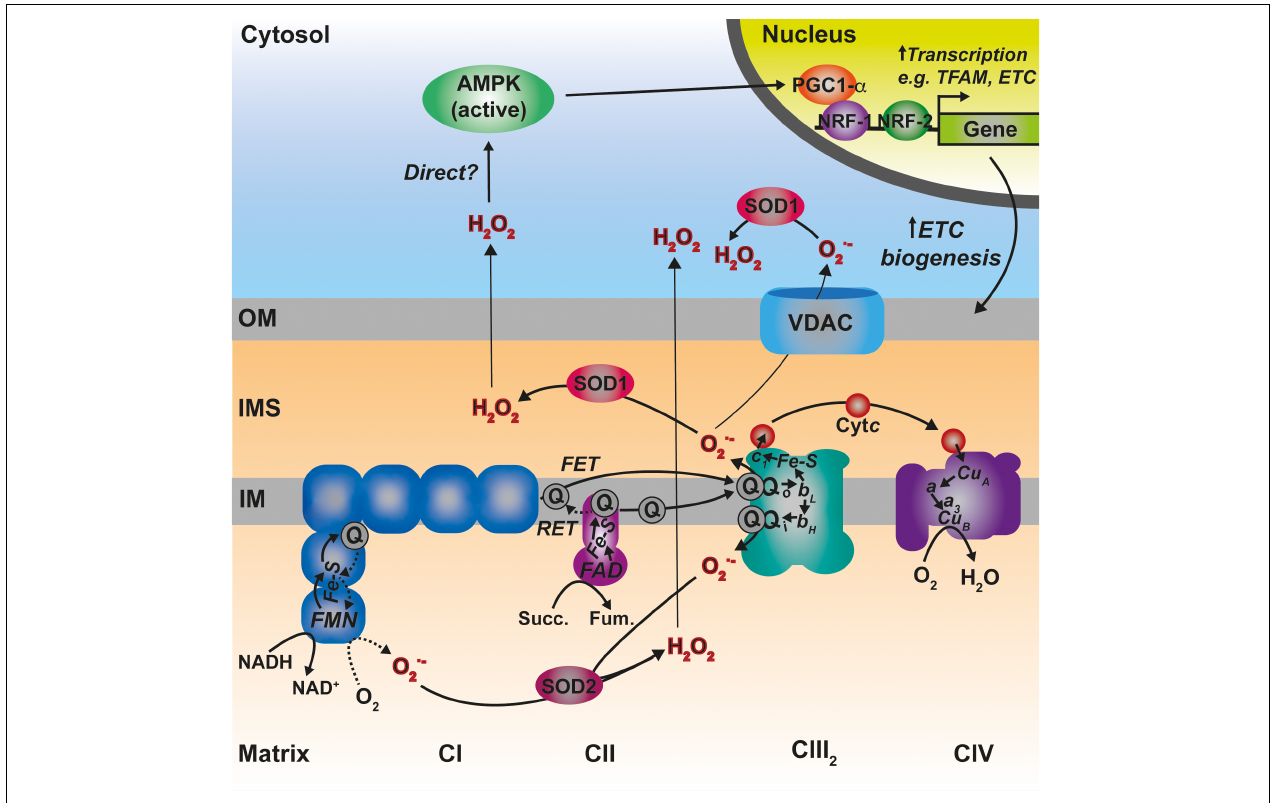
FIGURE 5 | Main sites of ROS generation by the ETC and possible pathways of ROS-mediated regulation of mitochondrial biogenesis. Complex I (CI) represented in blue, generates superoxide (O 2 − ) both via forward electron transfer (FET) or reverse electron transfer (RET) from a highly reduced coenzyme Q (Q) pool and high membrane potential. Two other prominent sites of O 2 − production are the two Q binding sites in CIII2 (Qo and Qi). O 2 − is dismutated to hydrogen peroxide (H 2 O 2 ) by the two differently localized superoxide dismutases SOD1 and SOD2. See main text for